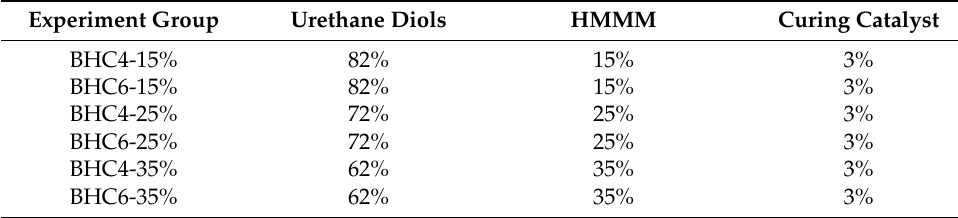
Figure 3. Chemical structure of ( a ) 1,10-decanediol and ( b ) 1,12-dodecanediol. Table 1. Formulation of MF coatings for the experimental group (wt.%).